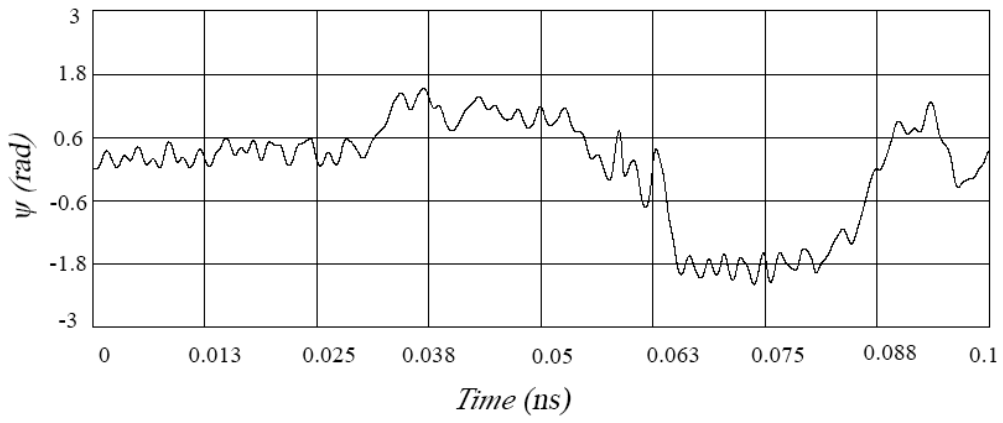
Figure 5. Angle between axis of proper rotation of fullerene and vertical axis of absolute reference system (nutation angle).